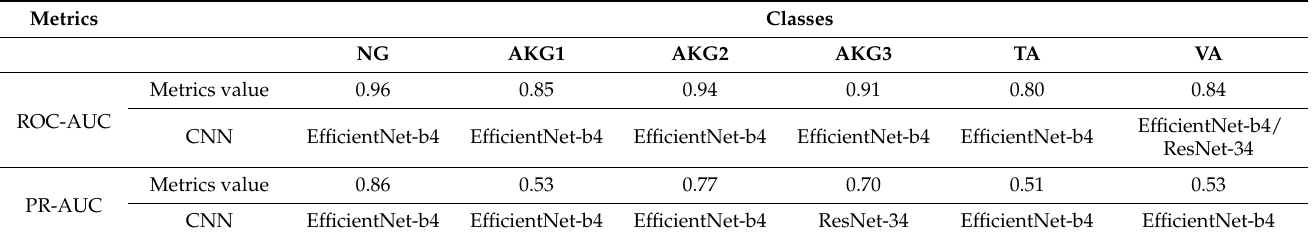
Figure 7. The quality of ResNet-34 prediction for all classes: ( a ) ROC-AUC metric and ( b ) PR- AUC metric. Table 4. The best results obtained for each class, according to ROC- and PR-curve